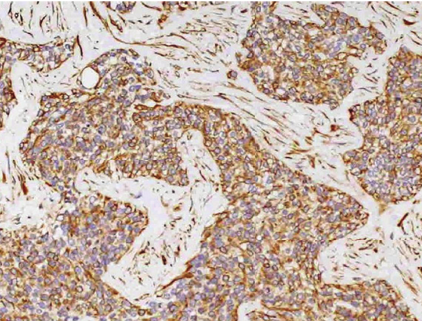
Figure 6: Immunohistochemical staining the cells demonstrated expression of EMA (original magnification, × 20).